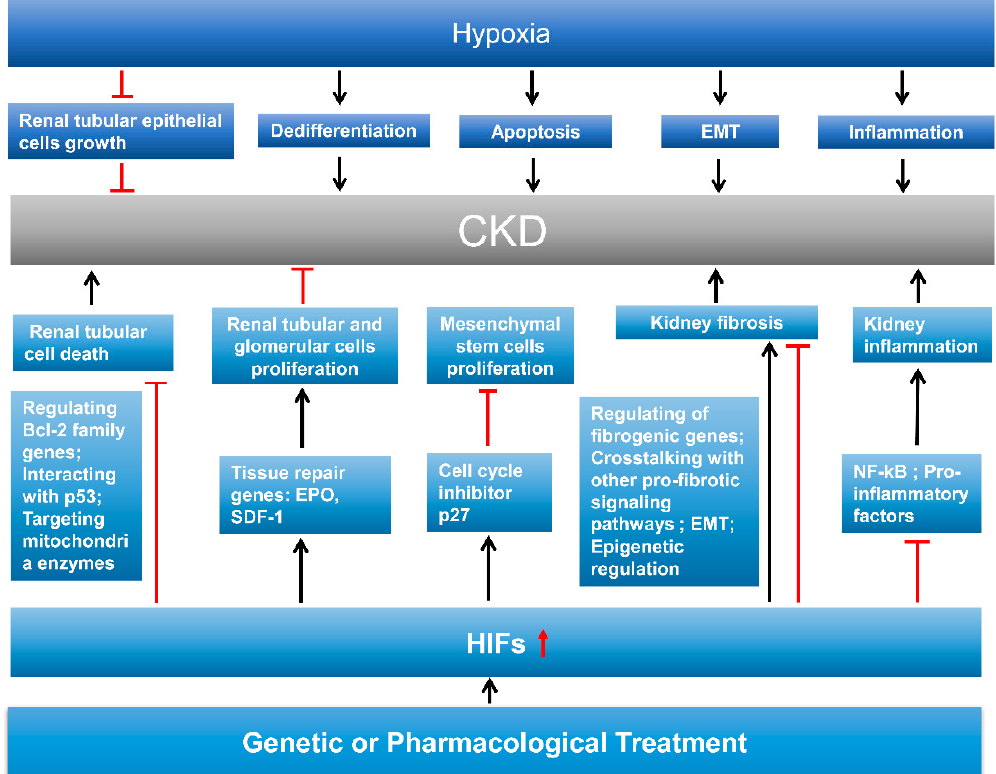
Figure 2. Role of hypoxia and HIF in kidney repair. Hypoxia accelerates the progression of CKD by inhibiting renal tubular epithelial cell growth and promoting dedifferentiation, apoptosis, EMT, and inflammation. Upregulation of HIFs by genetic or pharmacological treatment may (1) inhibit renal tubular cell death by regulating Bcl-2 family genes, interacting with p53, and/or targeting mitochondria enzymes; (2) promote renal tubular and glomerular cell proliferation by inducing tissue repair genes such as EPO and SDF-1 ; (3) inhibit mesenchymal stem cell proliferation by increasing the cell cycle inhibitor p27 expression; (4) promote or inhibit kidney fibrosis by regulating fibrogenic genes, cross-talking with other pro-fibrotic signaling pathways, EMT, and epigenetic regulation; and (5) inhibit kidney inflammation by reducing the expression of NF- κ B and pro-inflammatory factors. Abbreviations: epithelial-to-mesenchymal transition (EMT), chronic kidney disease (CKD), erythropoietin (EPO), stromal cell-derived factor-1 (SDF-1), and hypoxia-inducible factor (HIF).